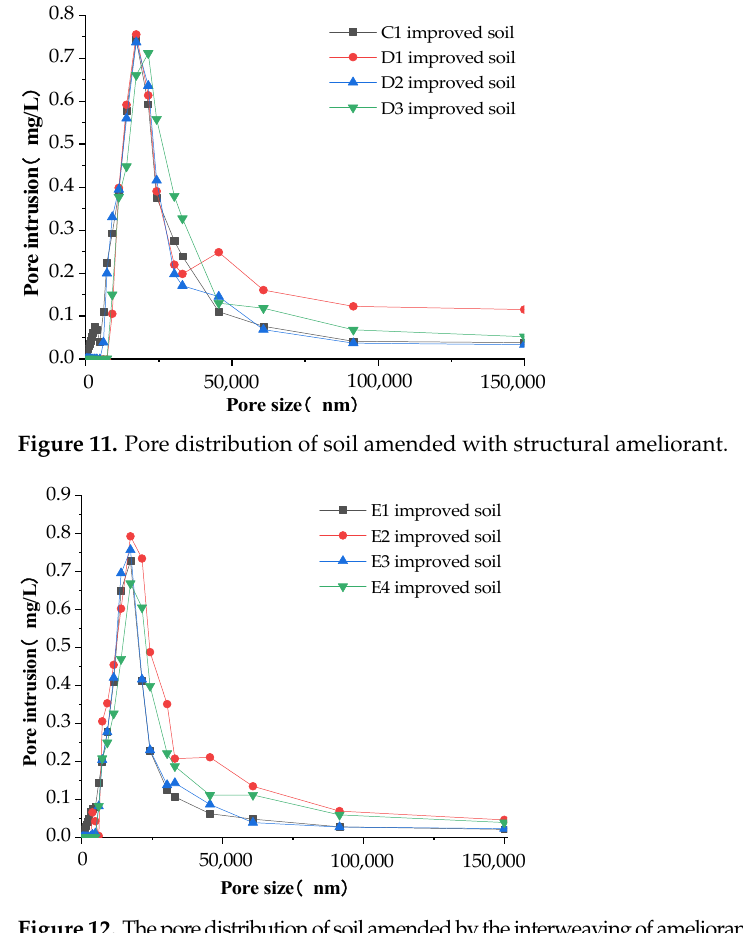
Figure 12. The pore distribution of soil amended by the interweaving of ameliorants and structural